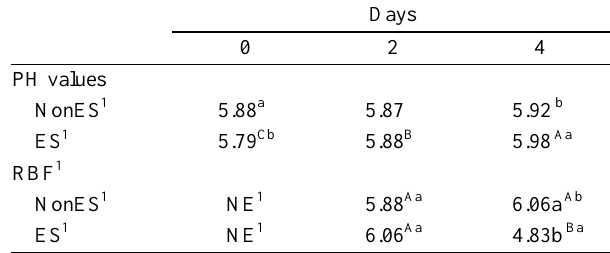
Table 2. Effect of electrical stimulation on pH values and roast beef flavor scores of precooked roast beef during refrigerated